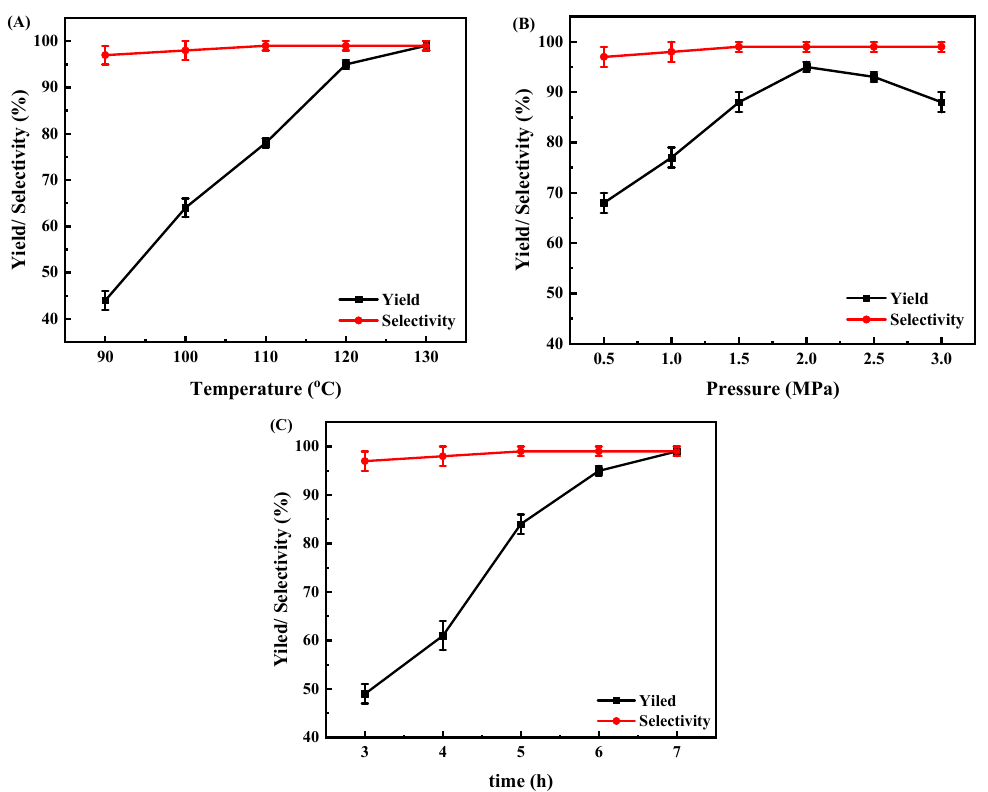
Figure 6. Effects of reaction parameters on CO 2 cycloaddition reactions over BP-CN-1. Reaction conditions: PO 34.5 mmol, 100 mg BP-CN-1, 100 mg Bu 4 NBr, ( A ) effect of reaction temperature, 2.0 MPa, 6 h; ( B ) effect of CO 2 pressure, 120 °C, 6 h; ( C ) effect of reaction time, 120 °C, 2.0 MPa.